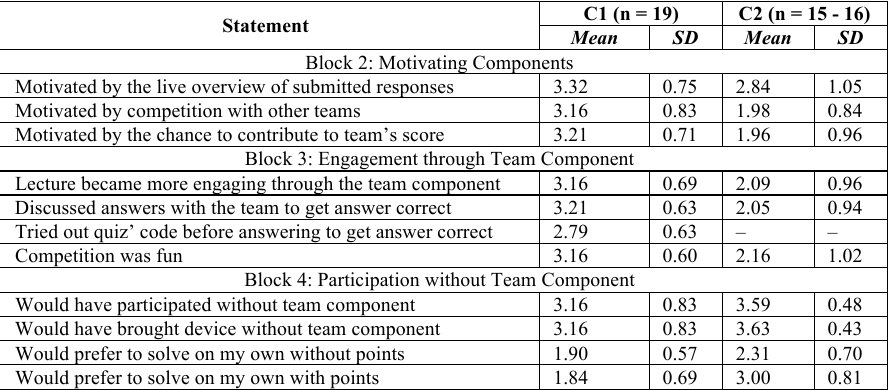
Table 4. Survey results for both courses. Strong agree was assigned a value of 4, agree a value of 3, disagree a value of 2, and strong disagree a value of